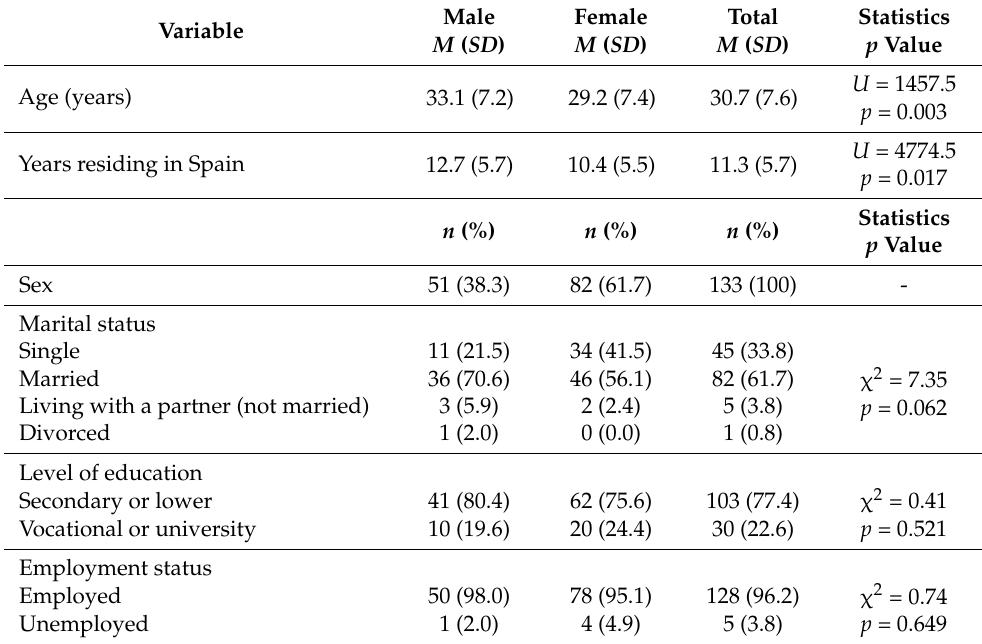
Table 3. Participants’